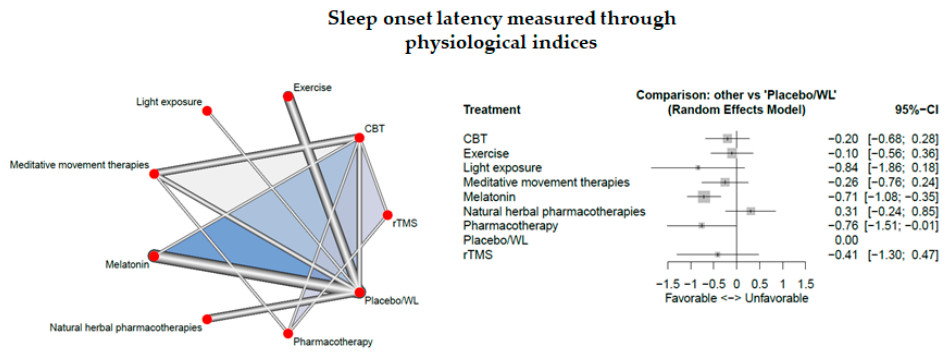
Figure 8. Sleep onset latency measured through physiological indices.